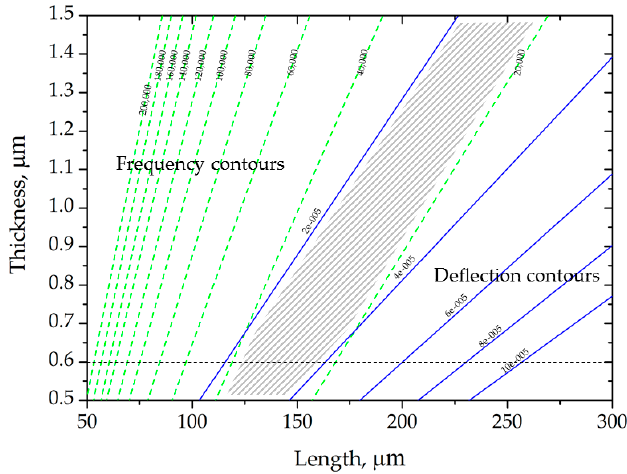
Figure 2. Design optimization of the simplified microcantilever for enhancing sensitivity in static mode sensing. The shaded area shows the optimum design space.